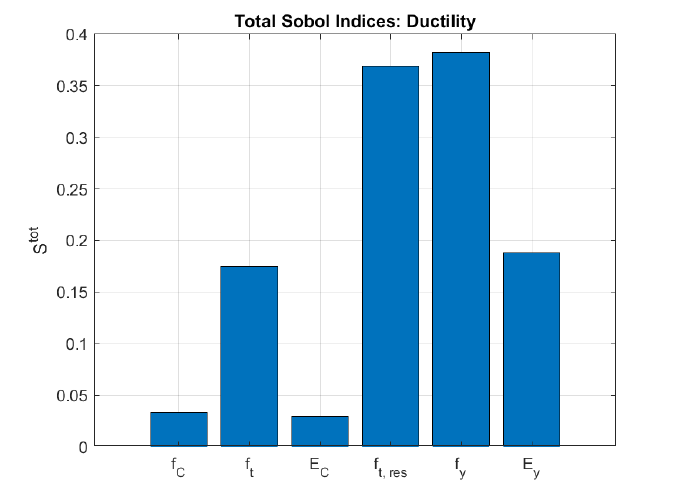
Figure 20. Total Sobol’ indices for